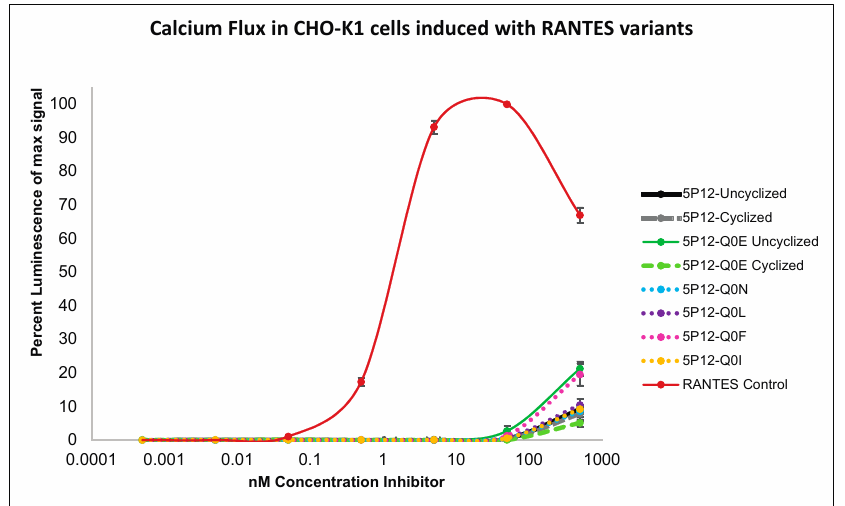
Figure 5. Calcium Flux Assay. CHO-K1 cells expressing CCR5 on their surface were incubated with various concentration of chemokine (either wild type RANTES/CCL5 or a 5P12-RANTES variant) and monitored for luminescence of aequorin upon calcium release. At very high “supraoptimal” concentrations, RANTES/CCL5 exhibits aggregation with alternate effects on receptor activation [31].